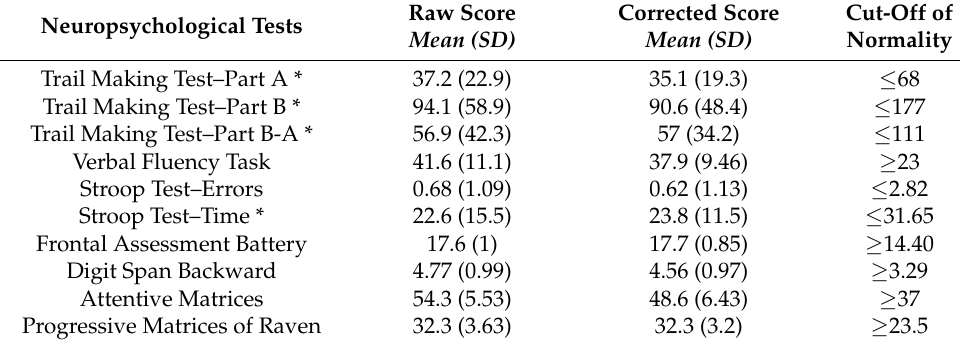
Table 4. Scores of neuropsychological assessment.